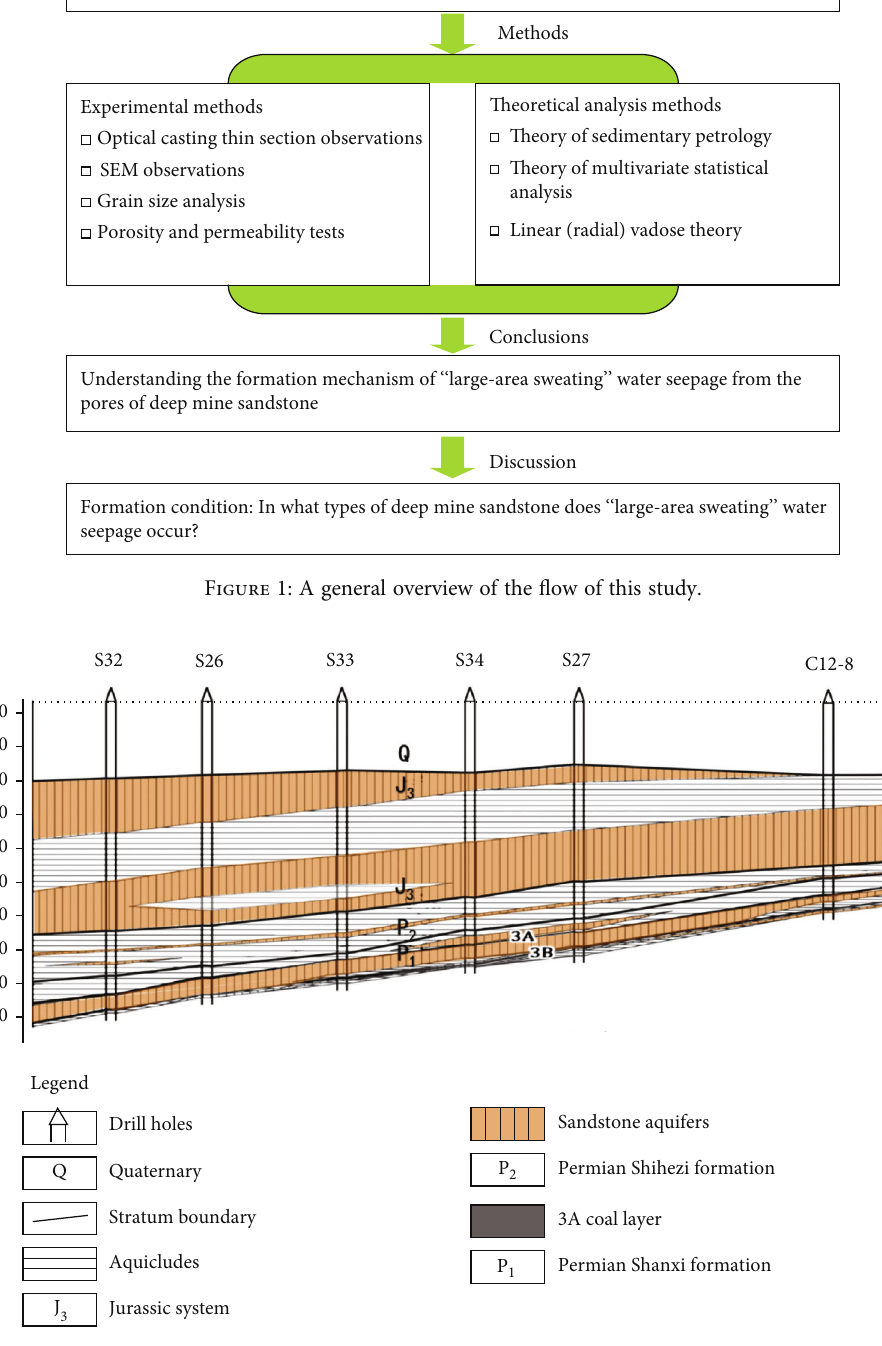
Figure 2: Distribution of samples into groups for laboratory research: (a) Jurassic sandstone; (b) Permian Shihezi Formation sandstone; and (c) Permian Shanxi Formation